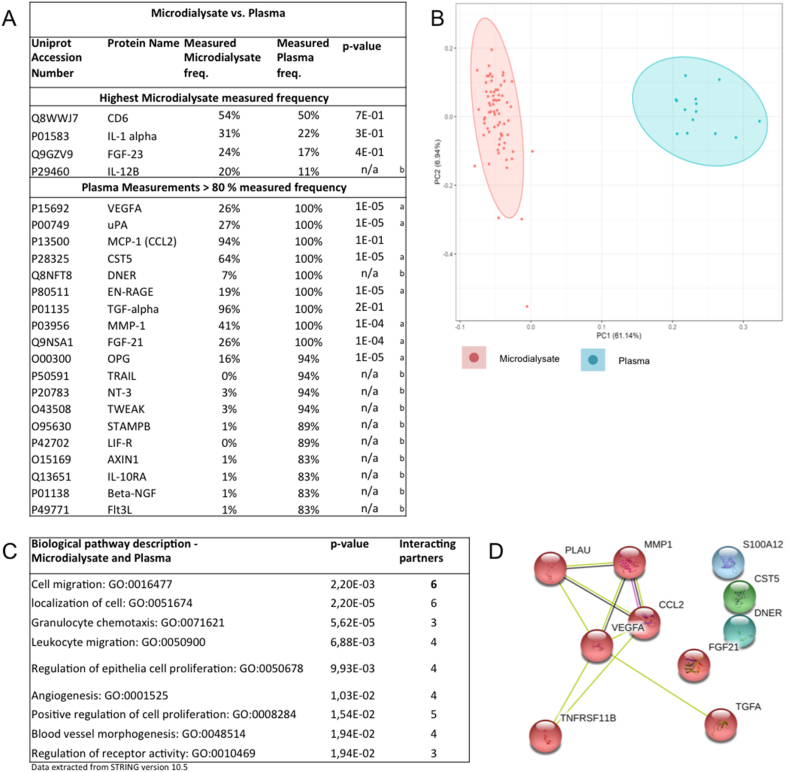
Key proteins of interest from the microdialysates and plasma. (A) Selected proteins of interest based on measured microdialysate freq. or measured plasma freq. (a) One-way ANOVA comparison between microdialysate and plasma. p-values <.05 were considered significant. (b) Not available information (n/a). (B) Principal component analysis (PCA) of microdialysate and plasma samples. Analysis was based on NPXs of all proteins for each individual samples (smaller dots). The ellipses indicate the percentage of variability by PC1 and PC2 using all individual samples for a given group. The colored ellipses denote 95% confidence intervals for the different groups. Each axis is labeled with the percent total variance. The two labels correspond to microdialysates (red) and plasma (blue). (C) Biological interaction of proteins measured in both microdialysates and plasma. Each description directs to a GO enrichment search p-value, involved partners, and GO terms. (D) Graphic representation of proteins identified to have a connection within both groups. The same coloring indicates stronger relation. Data are extracted from STRING version 10.5 (String-db.org). Protein and gene abbreviation of proteins with p-values <.05; T-cell surface glycoprotein Cd6 isoform, CD6; interleukin-1 alpha, IL-1 alpha; fibroblast growth factor 23, FGF-23; vascular endothelia growth factor A, VEGF-A; urokinase-type plasminogen activator, uPA (PLAU); monocyte chemotactic protein 1, MCP-1; cystatin D, CST5; delta and notch-like epidermal growth factor-related receptor, DNER; protein S100-A12, EN-RAGE (S100A12); transforming growth factor alpha, TGF-alpha (TGFA); matrix metalloproteinase-1, MMP-1; fibroblast growth factor 21, FGF-21; osteoprotegrin, OPG (TNFRSF11B).